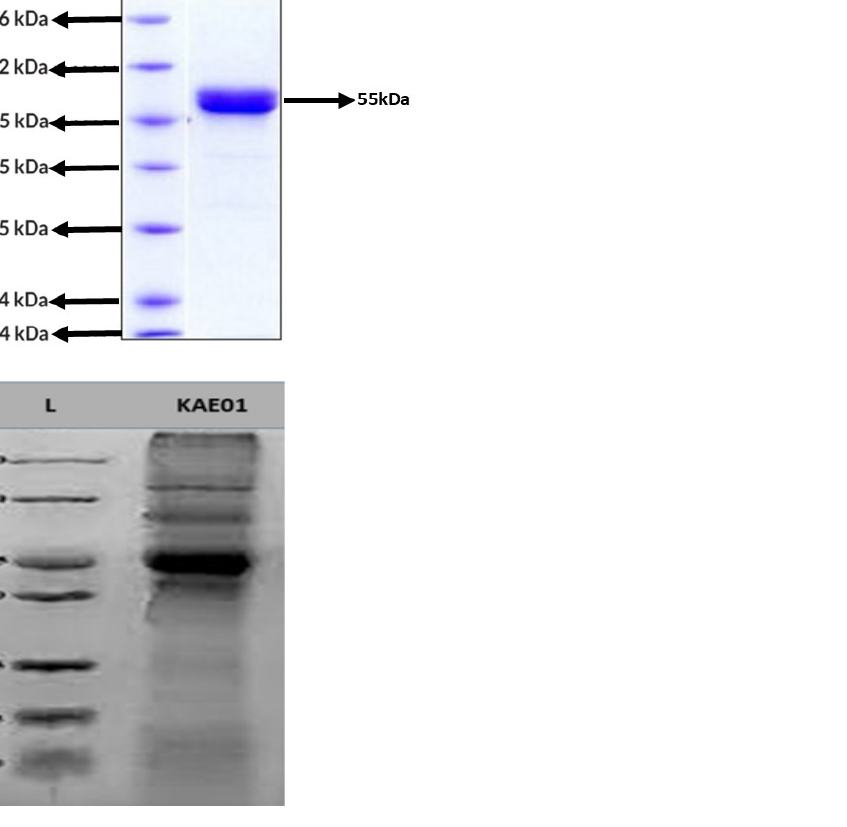
Figure 5. Identification of molecular weight of purified enterocin KAE01 using SDS-PAGE. Lane 1: standard molecular size ladder; Lane 2: purified enterocin KAE01 with approximate size of 55 kDA.